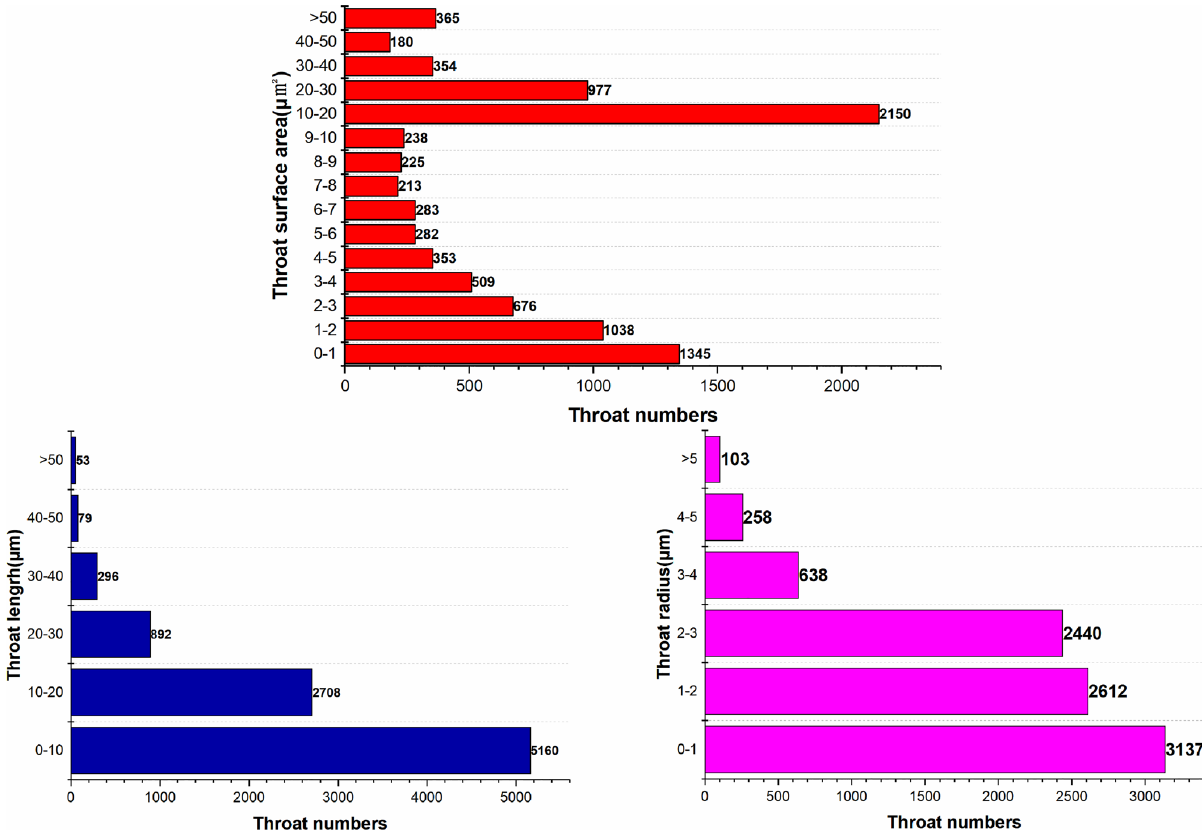
Figure 19. Statistics of throat quantitative parameters of nylon-uncured rubber sample.